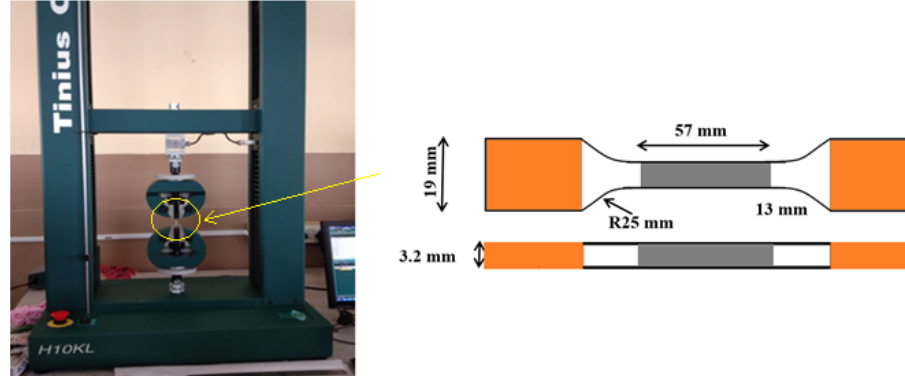
Figure 3. ASTM D638 based sample used for tensile testing.